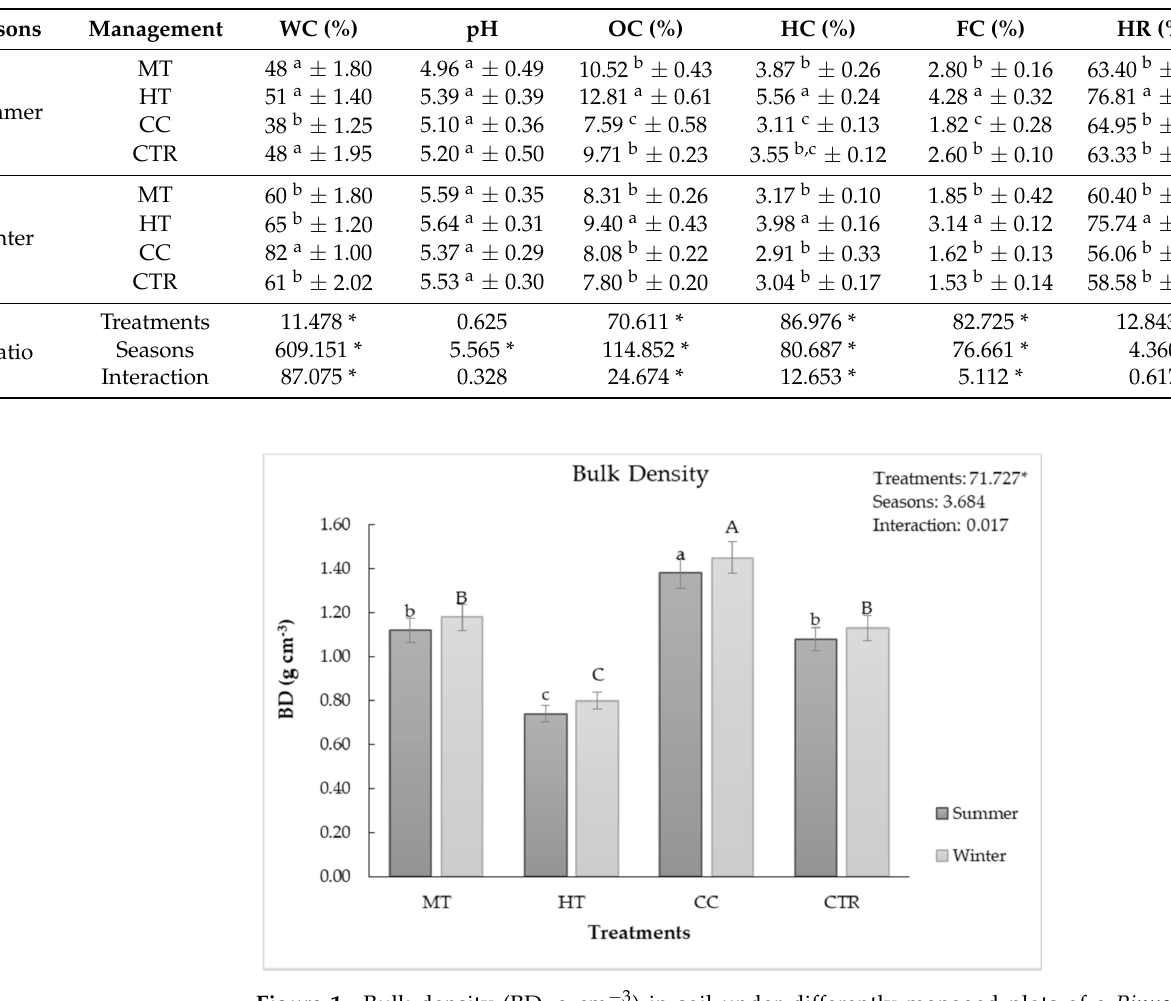
Table 2. Water content (WC), pH, organic carbon (OC), humic acid (HC), fulvic acid (FC), and humification rate (HR) in soil under differently managed plots (intensive thinning (HT), moderate thinning (MT), clear cut, (CC), and control (CTR)) of a Pinus laricio plantation in summer and winter. The data are the means of two consecutive years (2014 and 2015). Analysis of variance shows the effects of treatments, seasons, and their interactions. Different letters in the same column indicate, within each season, significant differences (Tukey’s test, p ≤ 0.05). * p < 0.05. Different letters in the same row show significant differences at p ≤ 0.05.